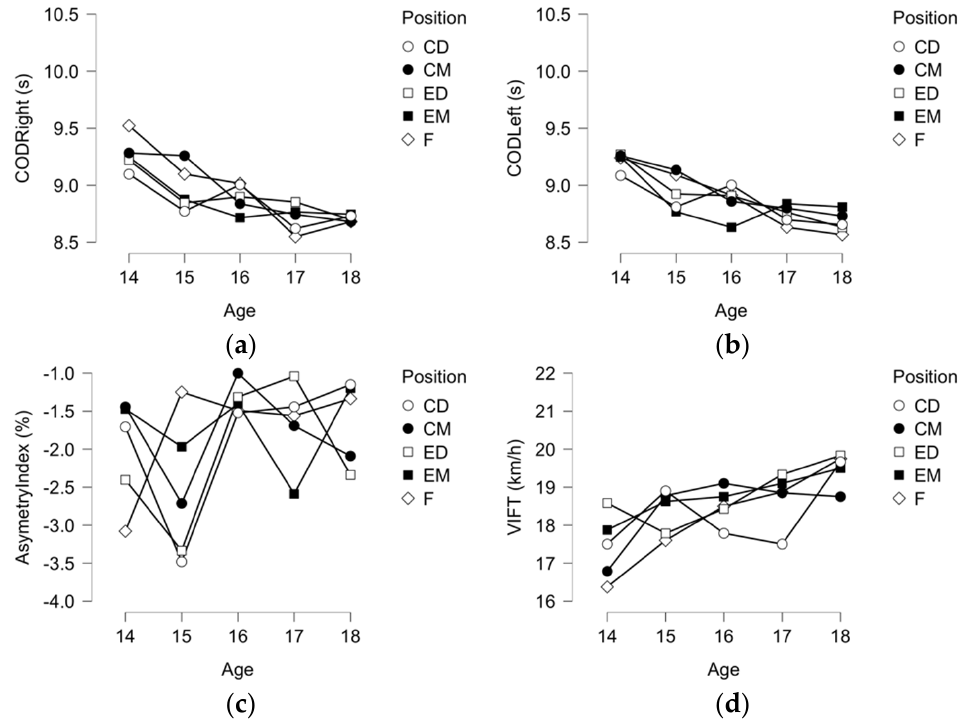
Figure 3. Descriptive plots ( a ) COD right leg (s); ( b ) COD left leg (s); ( c ) asymmetry index percentage (%); and ( d ) VIFT (km/h).